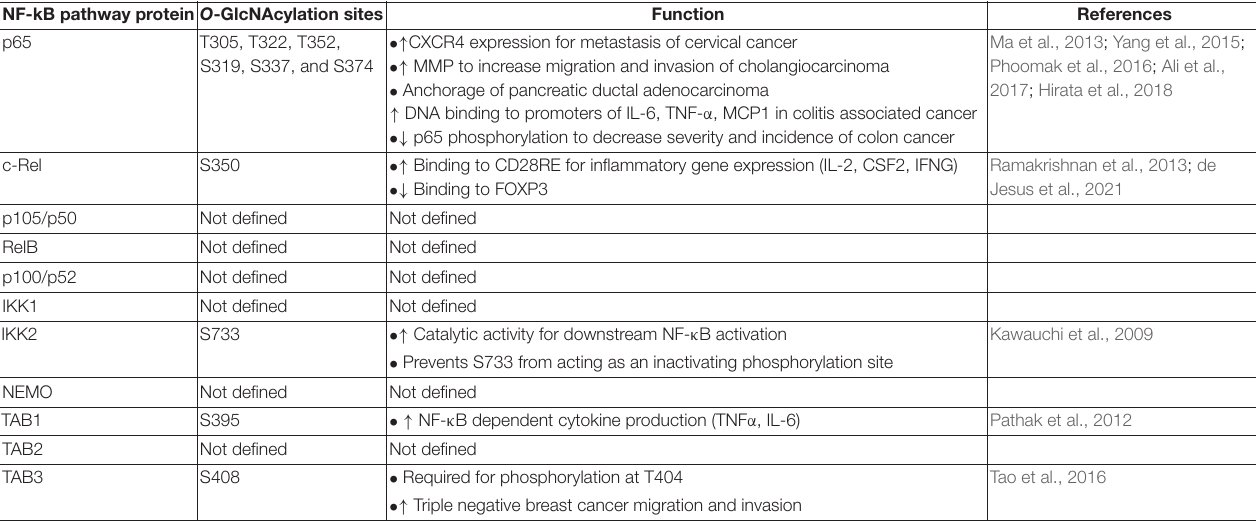
TABLE 1 | List of known O -GlcNAcylation sites and functions in the nuclear factor-kappaB (NF- κ B) pathway proteins. NF-kB pathway protein O -GlcNAcylation sites